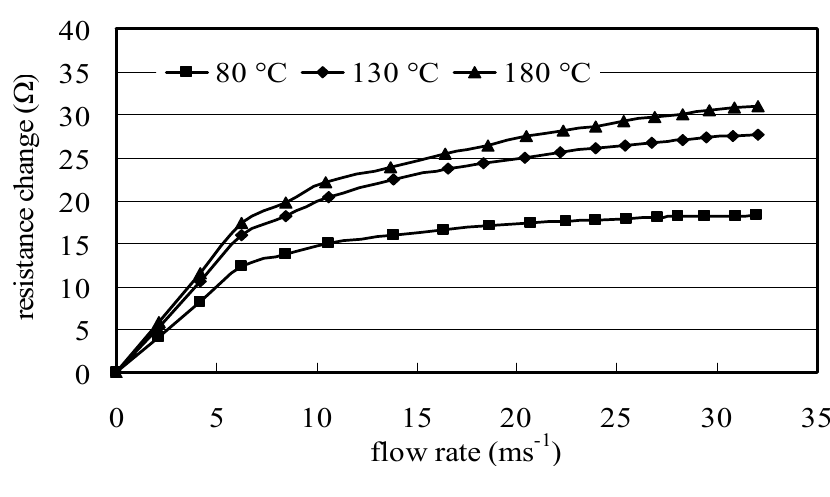
Figure 10. Variations of measured resistance change with flow rate for flow meter on diaphragm as function of micro-heater temperature where the initial resistances are 571.1 Ω , 594.8 Ω and 618.5 Ω , respectively (T = 80 °C, 130 °C, and 180